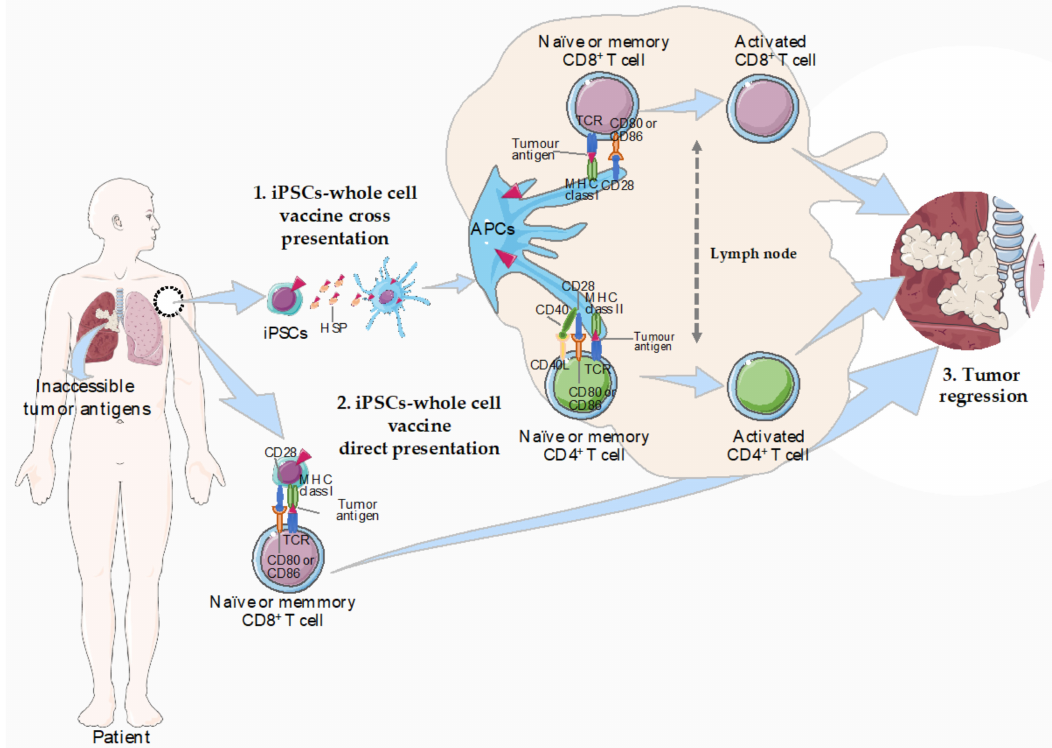
Figure 1. Possible pathways for immunogenic activation in response to autologous iPSCs-whole cell vaccines. In the indirect pathway (1), endogenous APCs uptake antigens in the patient’s body. The expression of HSPs in iPSCs is likely to promote cross-presentation by APCs (e.g., DCs) which are able to capture and process antigens, converting proteins to peptides that are presented on MHC molecules. This is followed by specific binding of a TCR on T cells in draining lymph nodes to its cognate peptide-MHC complex displayed on an APC-like, macrophages or DCs. Two signals are required for T-cell activation. Binding between the MHC / peptide complex on the APC and the TCR for antigen on the T cell is the first signal. The second signal is provided when co-stimulatory molecules (e.g., CD40 or CD80 / 86 on the APCs and CD40L or CD28 on T cells, respectively) are ligated. In the direct pathway (2), iPSCs express low levels of MHC class I and can directly present peptides to CD8 + T cells without the need of APCs. Still, cytokines secreted by activated T cells are necessary as recognition of antigen alone is insu ffi cient to induce full activation of naïve CD8 + T cells. As a result of T-cell activation, the APCs or T cells secrete cytokines that drive lineage di ff erentiation into e ff ector killing cytotoxic T cells that can lead to tumor regression (3). Abbreviations: APCs, antigen-presenting cells; DCs, dendritic cells; iPSC, induced pluripotent stem cell; MHC, major histocompatibility complex; TCR, T-cell